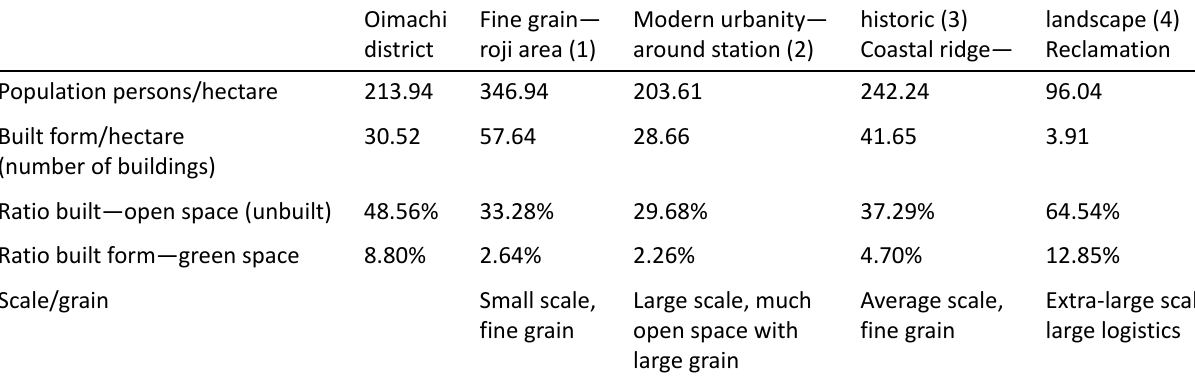
Table 1. Urban characteristics.